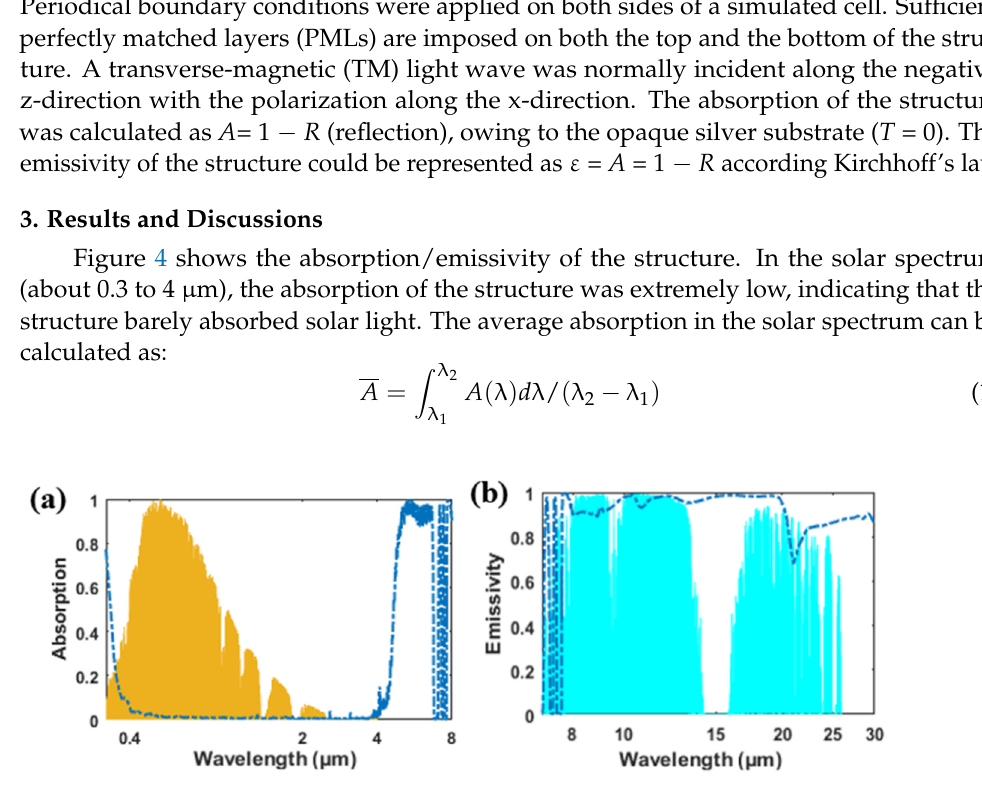
Figure 4. ( a ) Absorption of grating structure in Figure 1; normalized AM 1.5 solar spectrum is plotted in orange. ( b ) Emissivity of grating structure in Figure 1 in the atmosphere transparent window. The atmospheric transmittance is plotted in blue.